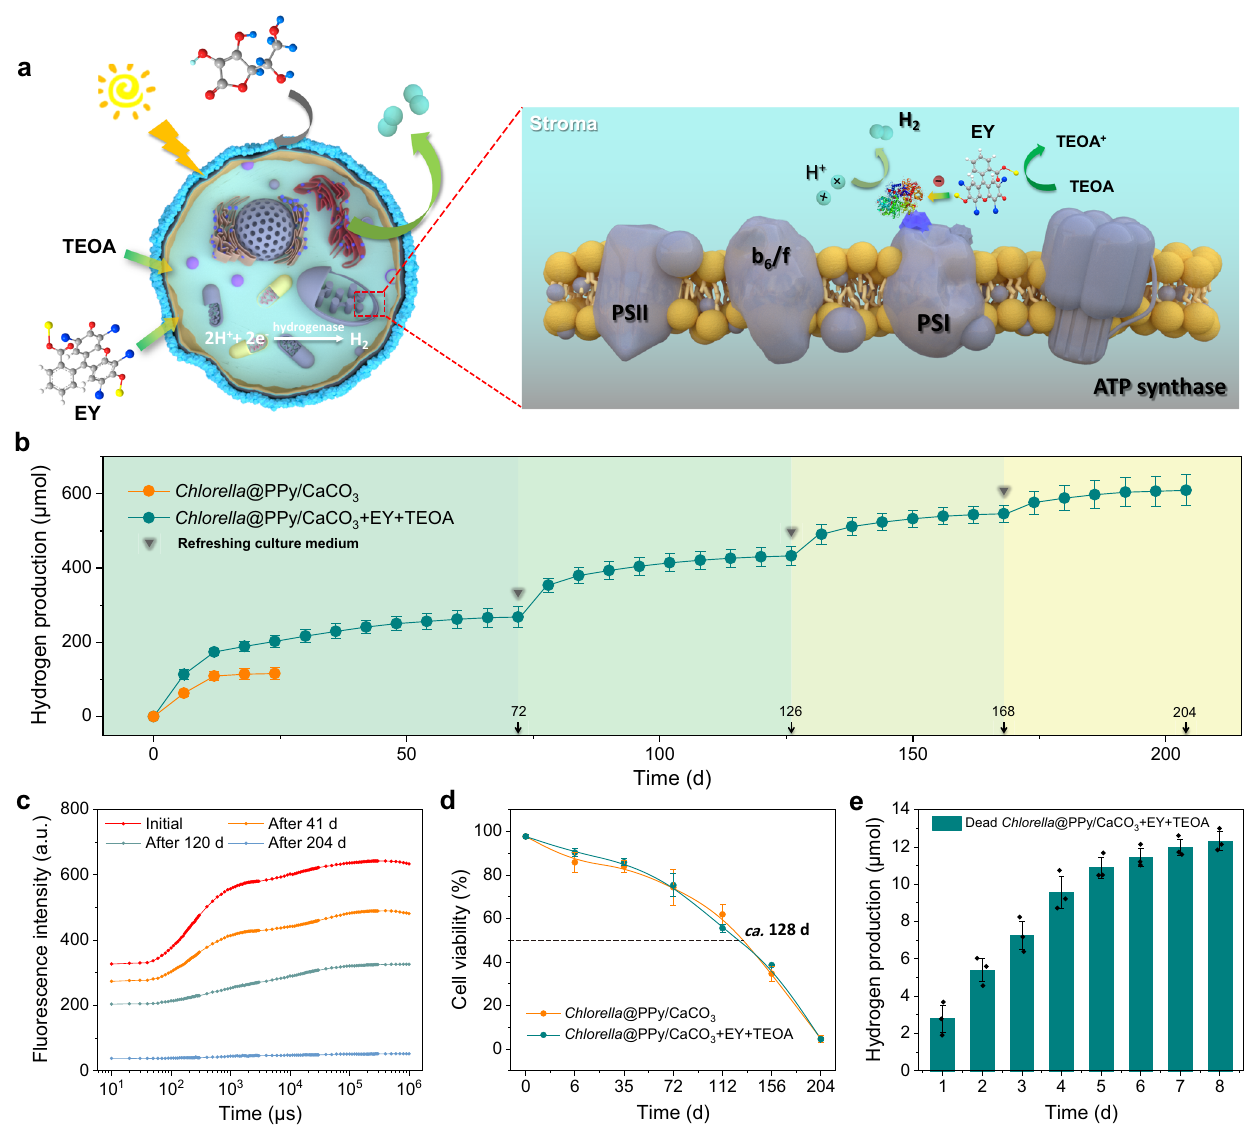
Fig. 5| Extracellularelectron-mediatedphotosynthesis-independent extended hydrogen production. a Schematic illustration of hydrogen production (paired cyancircles)arisingfromsurface-augmentedalgalcellswiththeadditionofEYand TEOA under hypoxic conditions. The electrons are directly transferred to hydro- genase via molecular diffusion; right panel shows the site of interaction with extracellular electrons. Molecular graphics for EY, TEOA and ascorbate are shown. b Time-dependent production of hydrogen for PPy/CaCO 3 -coated Chlorella cells with periodic addition of TEOA at intervals of 6 d from the time point of 12 d. The culture medium containing EY and TEOA is also refreshed (arrows) along with regeneration of the outer CaCO 3 shell. The fi nal used concentrations of EY and TEOAat 72d are 0.23and 16.8mg/mL; 126 d,0.23 and 13.9mg/mL;168 d,0.23and 11.0mg/mL; and 204 d, 0.23 and 9.52mg/mL. Average chlorophyll content obtainedwithin204d,38.3mg/L.Thedecreaseonthehydrogenproductionrateis